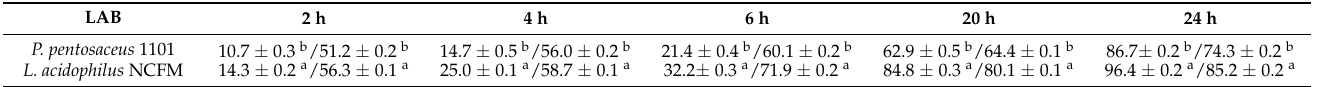
Table 5. Auto-aggregation/co-aggregation capacity (%) of LAB.